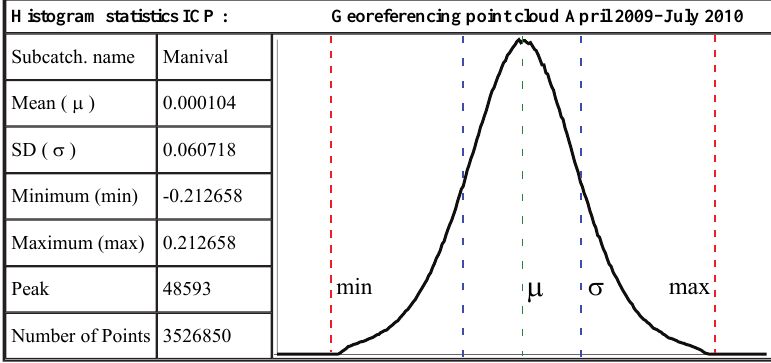
Figure 6. Distribution of the distance between two survey point clouds after the process of georeferencing using the ICP procedure. The distance approaches normal distribution with a zero mean, showing that errors generated by multiple scan registration and point cloud survey georeferencing are Gaussian, random, and independent. Data are given in metres. Table 3. Registration and georeferencing standard deviations (in centimetres) of the position uncertainty on a point by point basis that was used to derive the LoD at 95% confidence interval and subsequently to detect topographic changes down to a certain minimum volume of geomorphic